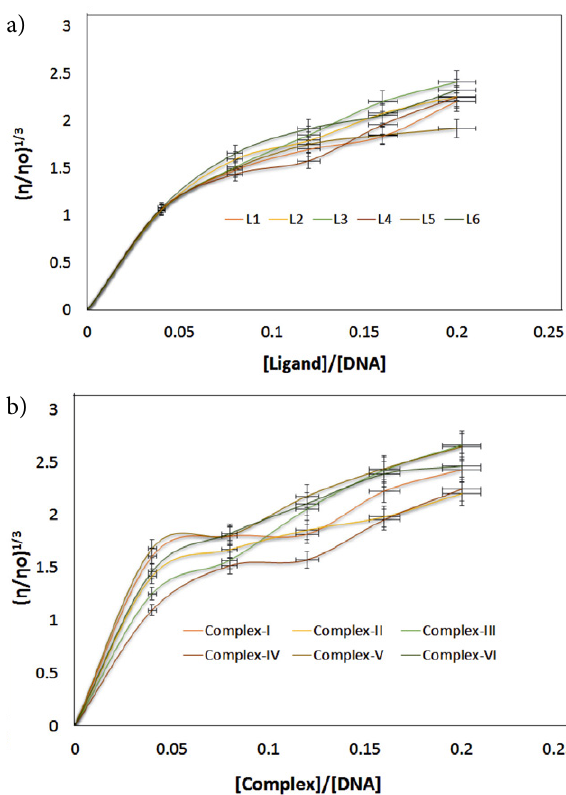
Figure 6. Effect of i ncreasing concentration of (a) ligands and (b) complexes on the relative viscosity of HS DNA at 27 (±0.1) °C in phosphate buffer at pH =